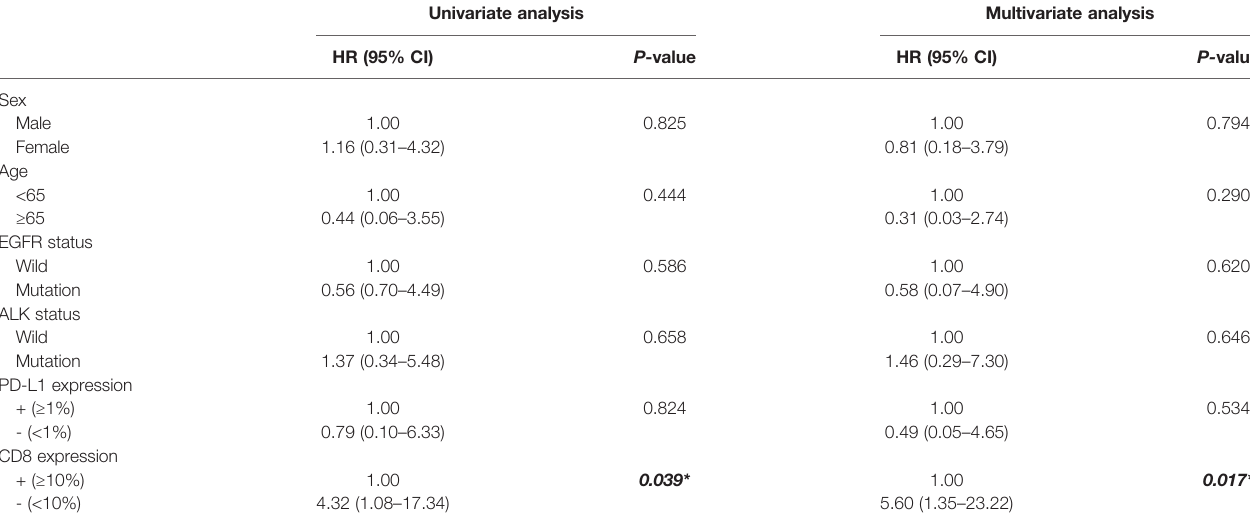
TABLE 2 | Univariate and multivariate Cox regression analyses of prognostic factors for survival in patients with IMA. Univariate